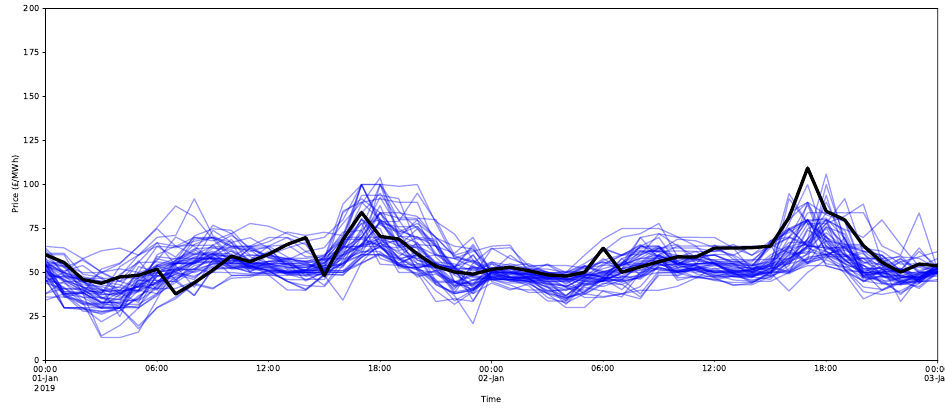
Figure 23. Example of 50 ensembles (blue) for the X-model method for the first day of the test set. The actual price is in